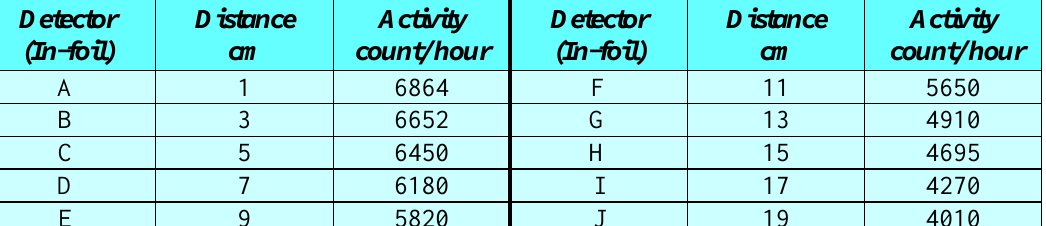
Fig.3: Fermi Age for Graphite material using the activation of Indium foil technique.